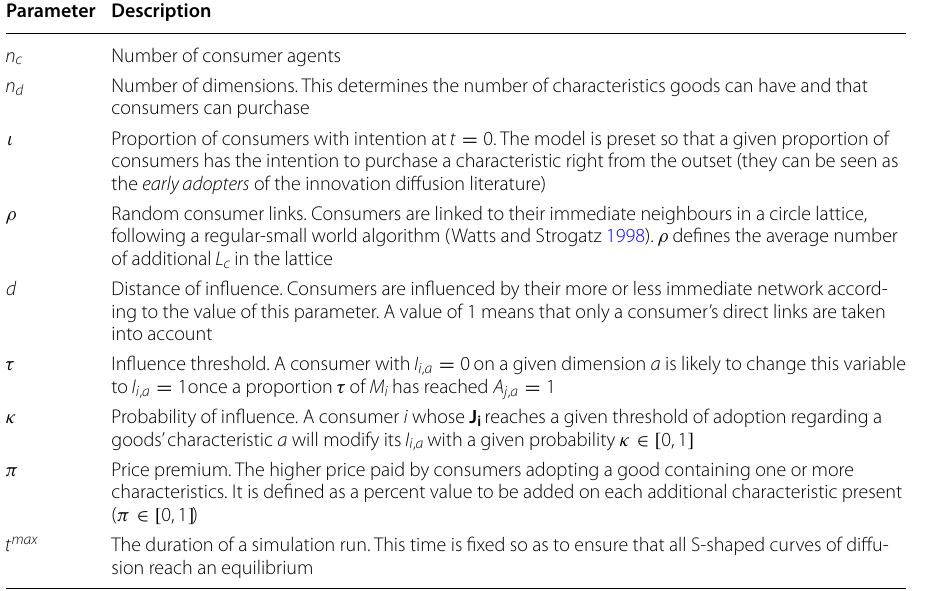
Table 4 Model’s parameters and their description Parameter